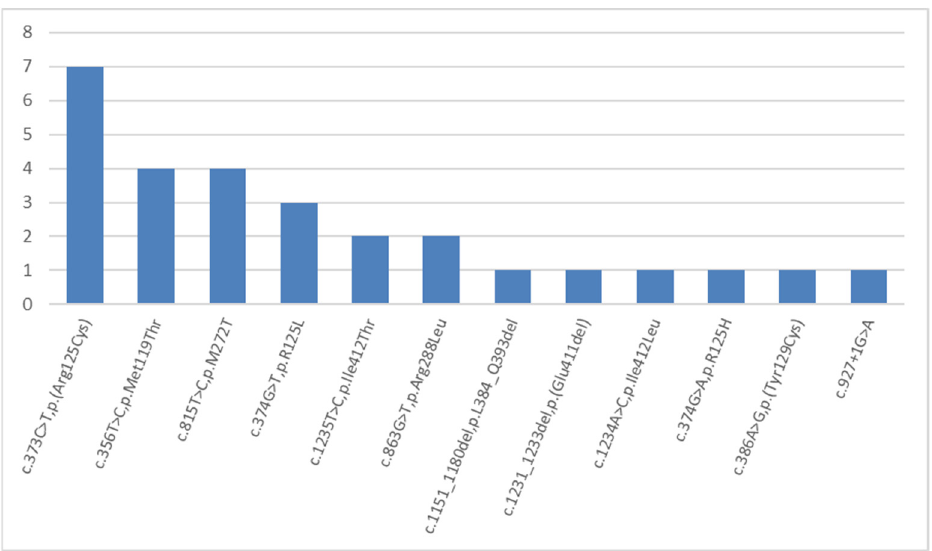
Figure 4. The frequencies and spectrum of detected mutations in the KRT14 gene in Russian children with an EB phenotype.